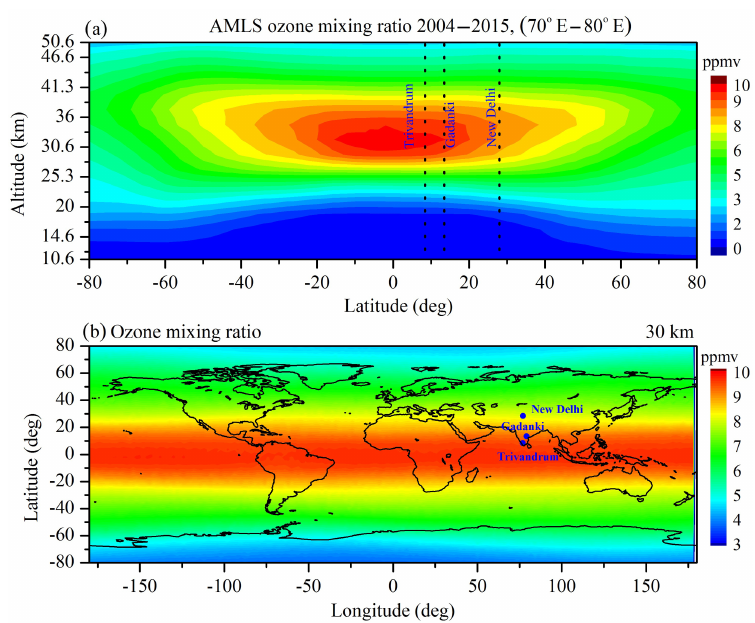
Figure 4. (a) Zonally averaged (70–80 ◦ E) ozone mixing ratio over the Indian subcontinent obtained from AMLS during 2004–2015. (b) Time averaged ozone mixing ratio contour at 30km obtained from AMLS during 2004–2015.